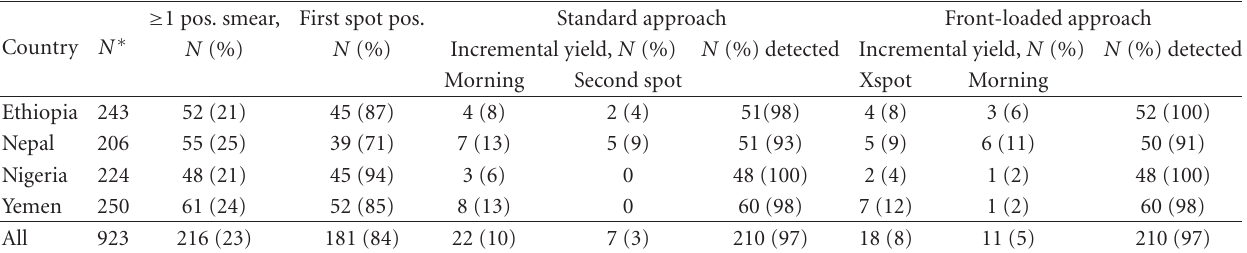
Table 1: Incremental yield of serial smears collected as spot-morning-spot or spot-Xspot-morning specimens. Country N